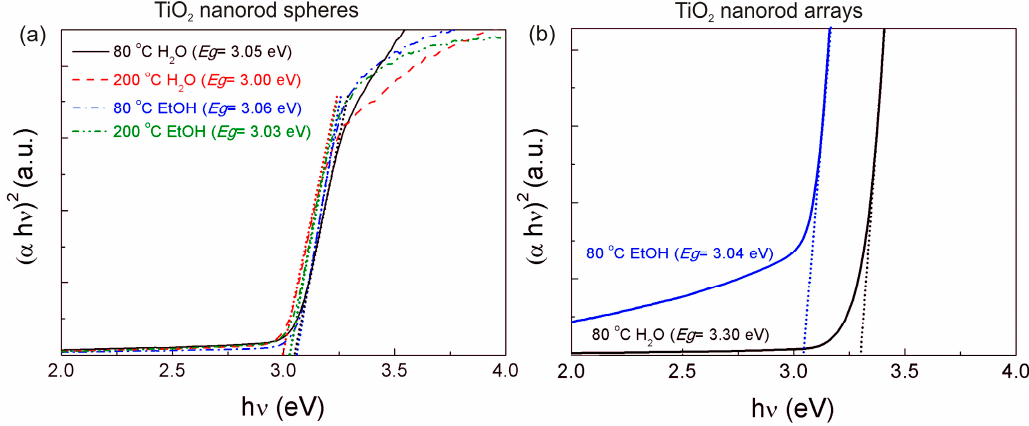
Figure 6. ( α h ν ) 2 variation versus photon energy h ν for the TiO 2 nanorod: ( a ) spheres; and ( b ) arrays.